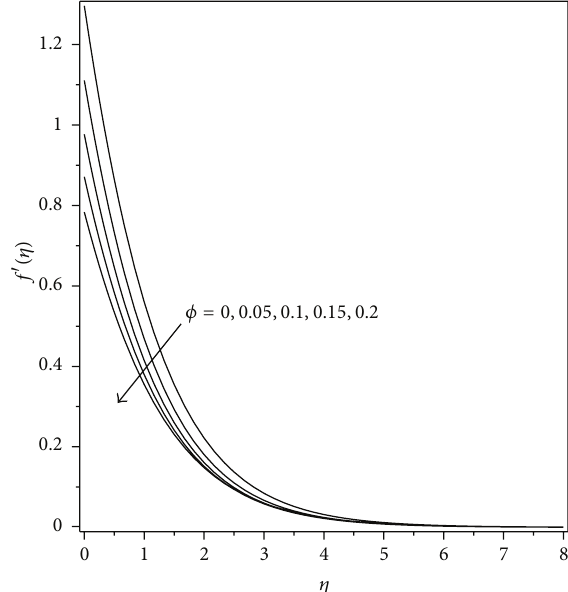
Figure 4: Variation of −𝜃 󸀠 (0) with 𝜙 for different types of nanopar- ticles when Pr = 6.2 and 𝑚 = 0 .